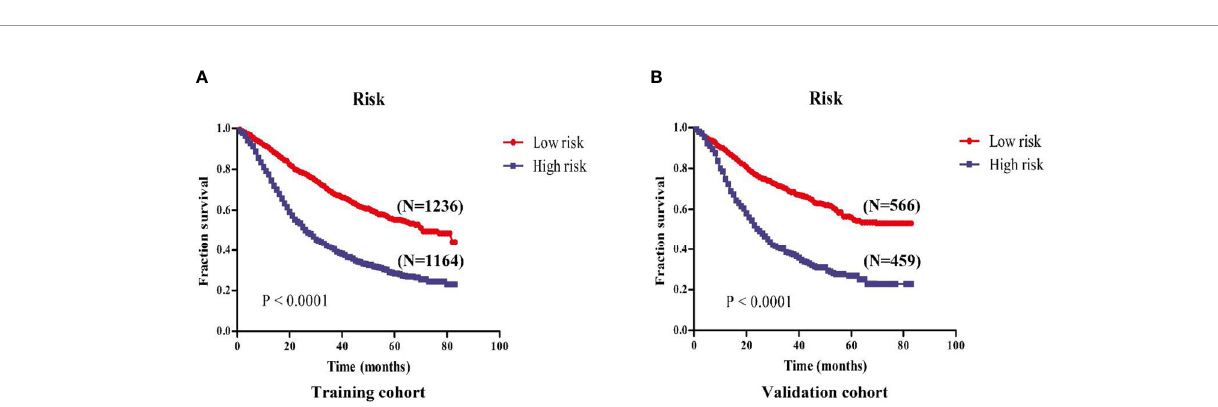
FIGURE 8 | Kaplan-Meier survival analysis revealed that the prognosis of patients in the high- and low-risk groups in the training and validation cohorts. (A) Training cohort; (B) Validation